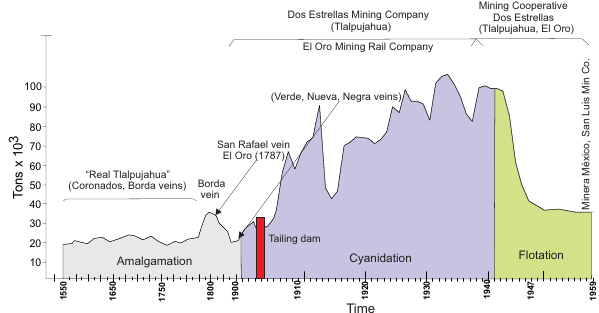
Figure 3. Historical record of the amounts of material extracted by the mining company (1898–1938) and mining cooperative “Dos Es- trellas” (1939–1959) and the relationships with the metallurgical processes used (after Uribe Salas, 2008).